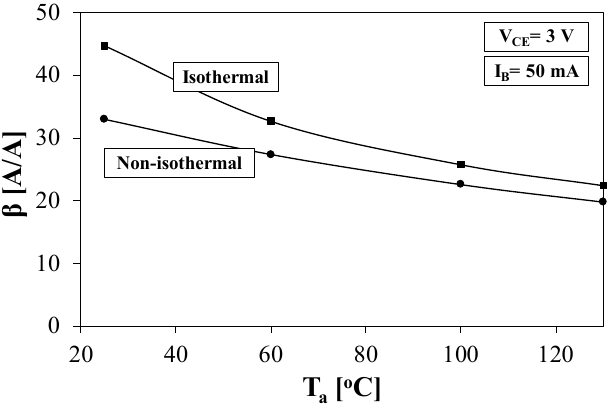
Figure 7. Isothermal and non-isothermal dependence of the current gain factor.